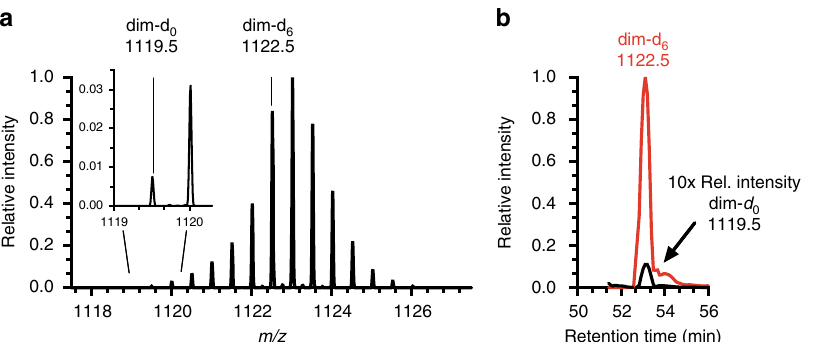
Fig. 1 LC – MS/MS Quanti fi cation of Cys-277 sulfenylation. Recombinant Src ( ∼ 0.6 µ g/ µ L) was either incubated with 1.0 mM of light dimedone (dim-d 0 ) in the absence of H 2 O 2 or treated with 1.0 mM H 2 O 2 in the presence of 1.0 mM heavy dimedone (dim-d 6 ) to trap sulfenylated cysteine residues. Equal amounts of dim-d 0 and dim-d 6 Src were combined prior to trypsin digestion and LC – MS/MS analysis. a Representative MS1 spectrum exhibiting peaks corresponding to the dim-d 0 - ( m/z 1119.5, inset) and dim-d 6 -conjugated ( m/z 1122.5) Cys-277 containing peptide fragment LGQGCFGEVWMGTWNGTTR (2 + charge). b Representative extracted ion chromatograms (with deuterated version eluting slightly earlier) from peptide-targeted parallel reaction monitoring (PRM) of dim-d 0 (black, relative intensity multiplied by ten) and dim-d 6 (red) enabling the determination of relative amounts of dim-d 6 /dim-d 0 corresponding to a heavy to light (H/L) ratio of 78.57 ± 5.54 (triplicate analysis). H/L ratio was calculated from the fi ve transitions from three experimental